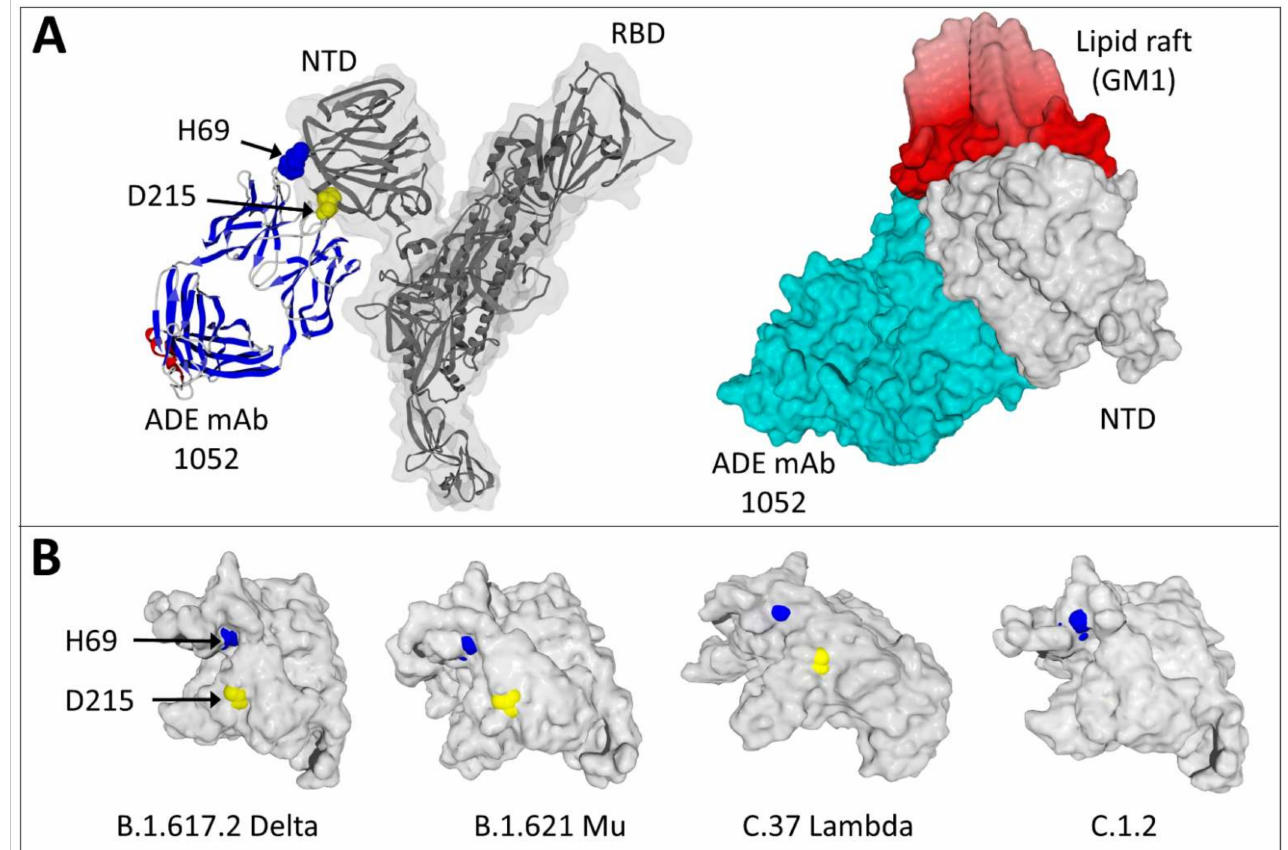
Figure 4. Critical amino acid residues control the binding of the ADE antibody 1052 to variant spike proteins. ( A ) Binding of the 1052 antibody (ADE mAb) to the Wuhan spike protein (PDB: 7LAB) with the NTD and RBD indicated. In the left panel, the light and heavy chains of the antibody are represented in standard secondary structures (red, α -helix, blue, β -strand). H69 (in blue atomic spheres) and D215 (in yellow atomic spheres) are highlighted. In the right panel, a surface representation illustrates the geometric complementarity of the Delta spike protein-antibody complex bound to a cluster of gangliosides GM1 figuring a lipid raft on the plasma membrane of a host cell. Note that the 1052 antibody b simultaneously binds to the NTD of the spike protein and to the edge of the lipid raft. ( B ) Molecular modeling of the NTD of several SARS-CoV-2 variants showing different levels of surface exposure of H69 (in blue) and D215 (in yellow) amino acid